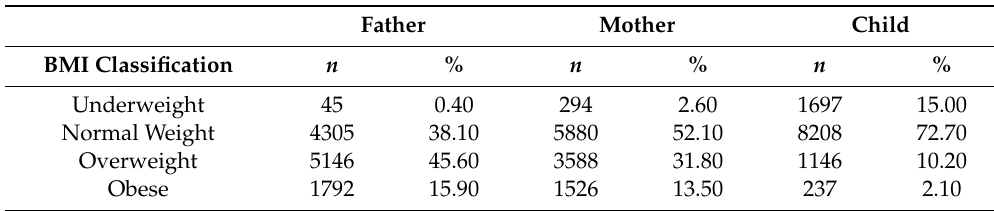
Table 1. BMI classification of parents and